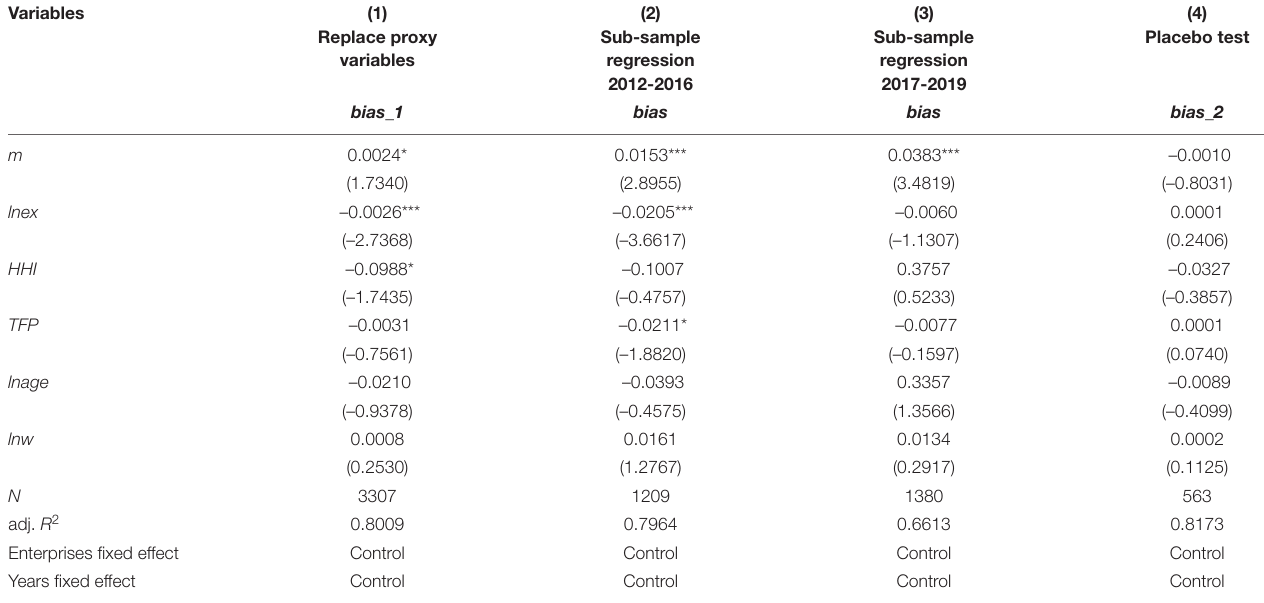
TABLE 7 | Robustness